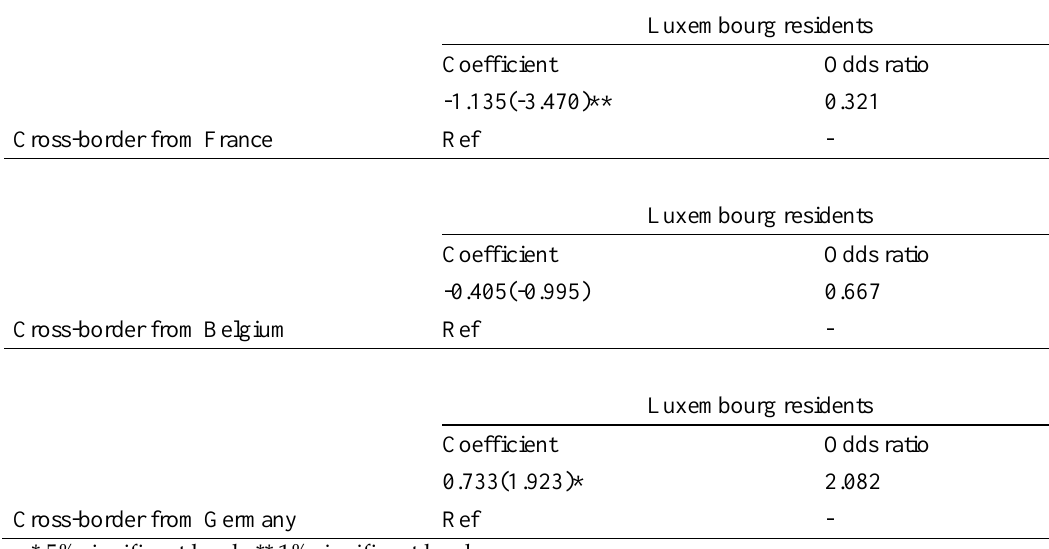
Table 4. Model 2a: Three barrier effects close to the border: results for unsustainable travel mode